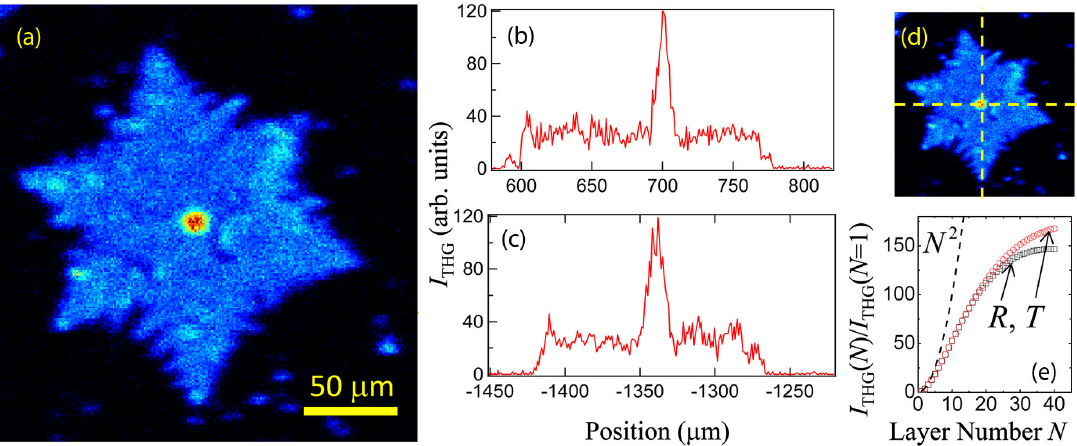
FIG. 5. (a) TH p -in/ p -out scan of graphene star ‘‘A’’ shown in Fig. 4(a). (b) and (c) Line-scan data along the dashed vertical and horizontal lines that pass through the central spot, as shown in (d). (e) calculated layer dependence of THG for reflected signals ( R ) using Eq. (1b) and transmitted ( T ) signals normalized to a monolayer signal; quadratic dependence is shown for reference (dashed).